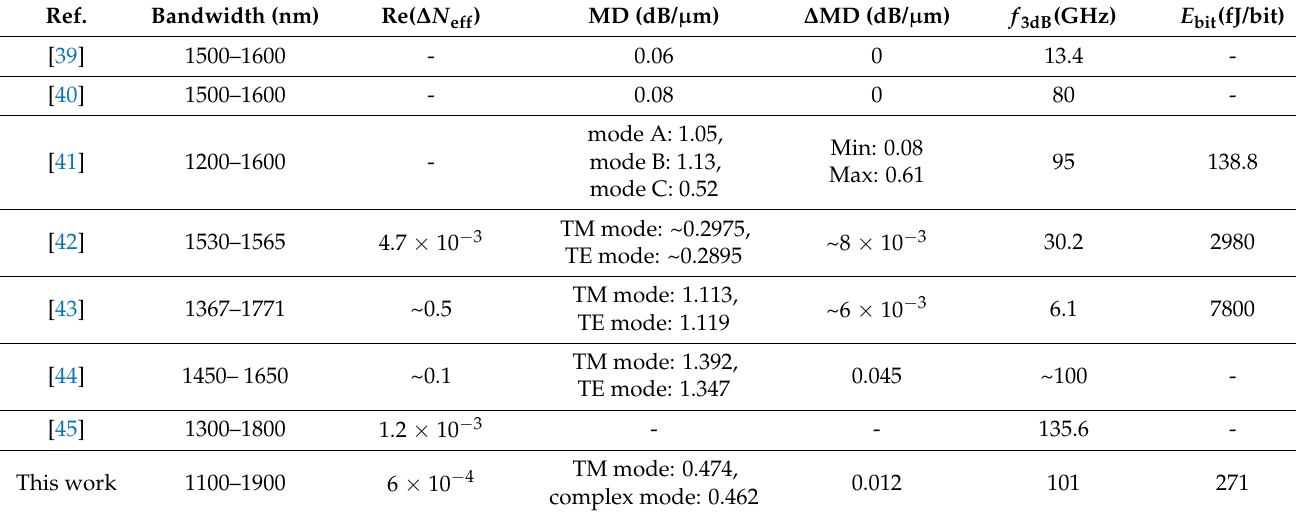
Table 1. Performance comparison with reported polarization-insensitive graphene modulators at λ = 1.55 µ m.